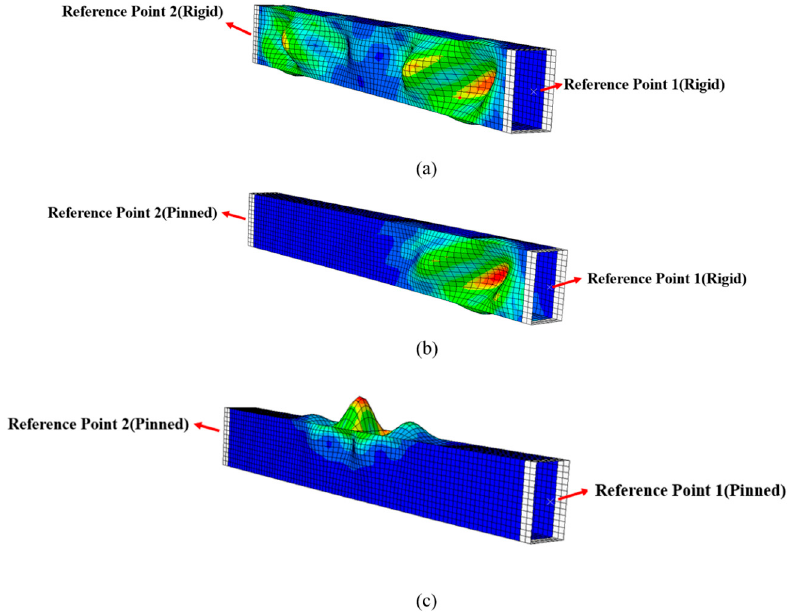
Figure 28. ( a ) Buckling mode of the rigid–rigid perimeter beam; ( b ) buckling mode of the rigid–pinned perimeter beam; ( c ) buckling mode of the pinned–pinned perimeter beam.